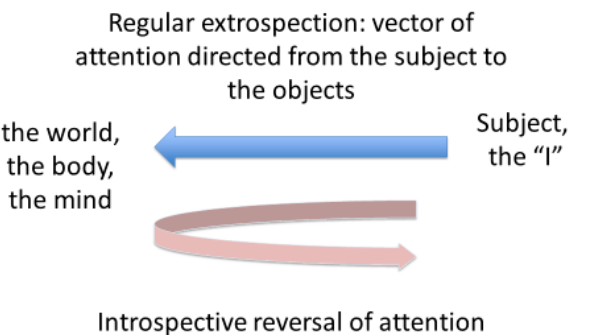
Figure 5. Introspective absorption of attention Table 4. Forms of Embodied Introspective Transcendence and Corresponding Religious Ideas and Psychological Changes. 103 Form of Introspective Experience Religious Ideas Psychological Changes